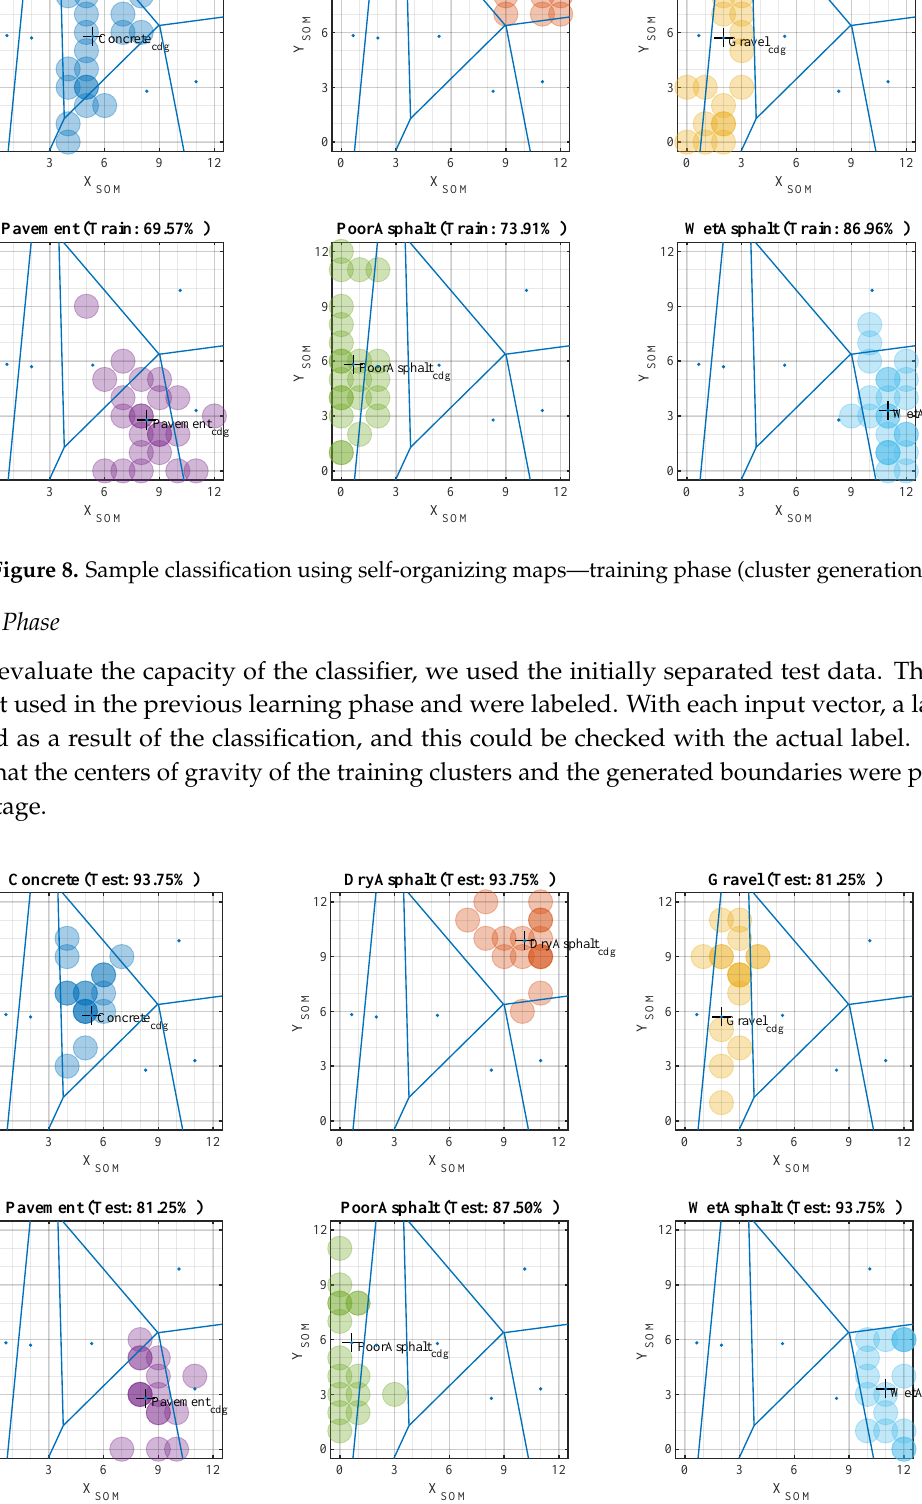
Figure 9. Sample classification using self-organizing maps—test phase (validation